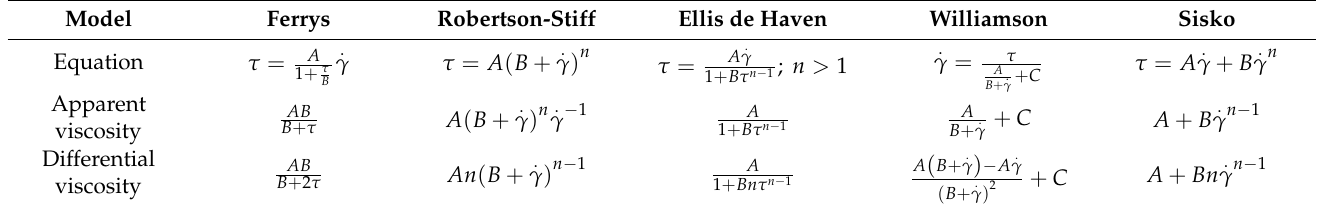
Table 1. The rheological model evaluated in the framework of the